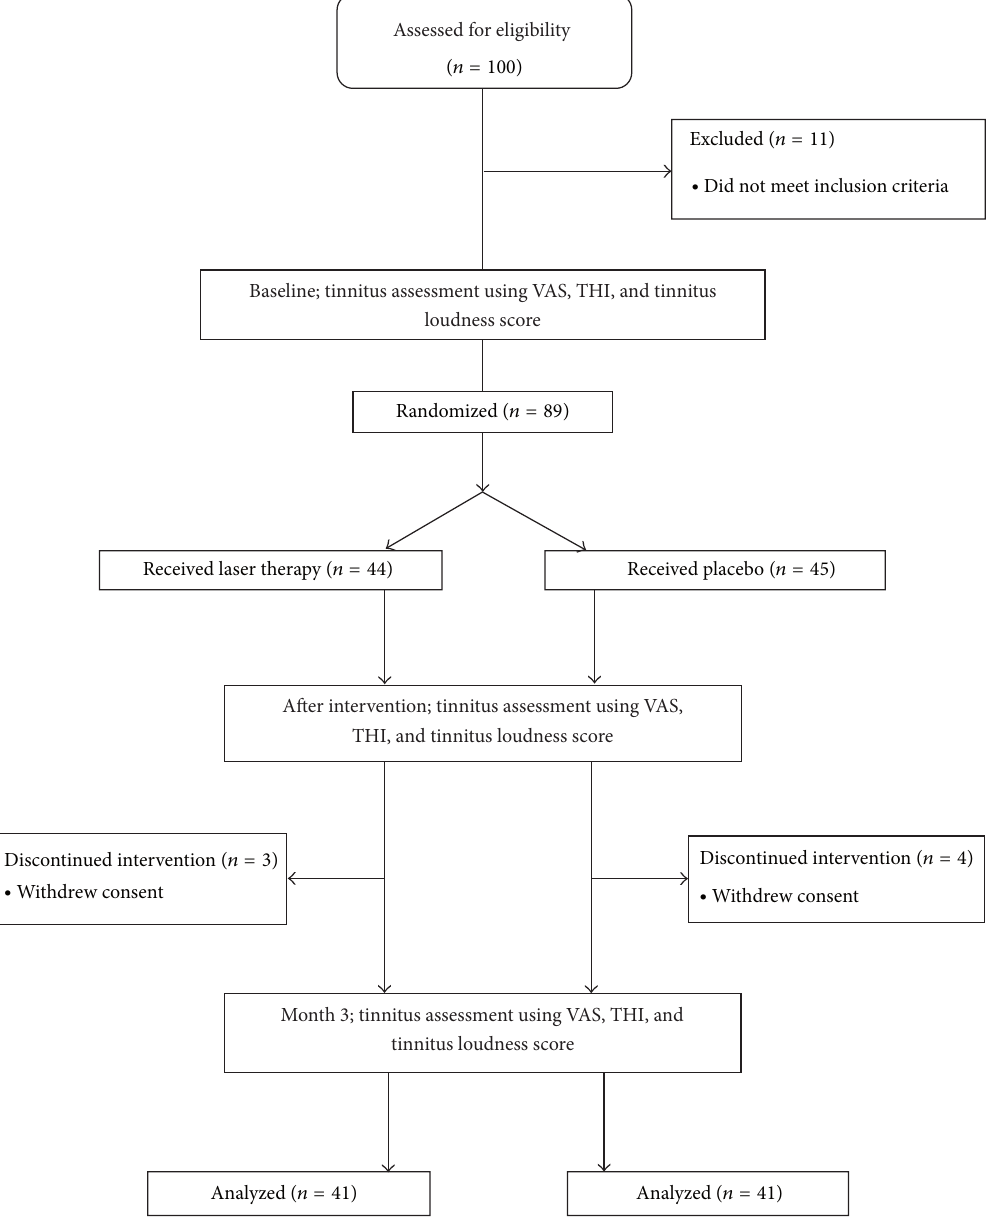
Figure 1: Study flow